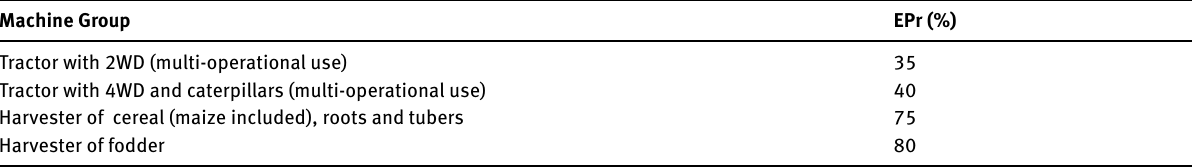
Table 3: Values for the annual average ratio of equivalent power engine to rated power engine (EPr) for different group of agricultural